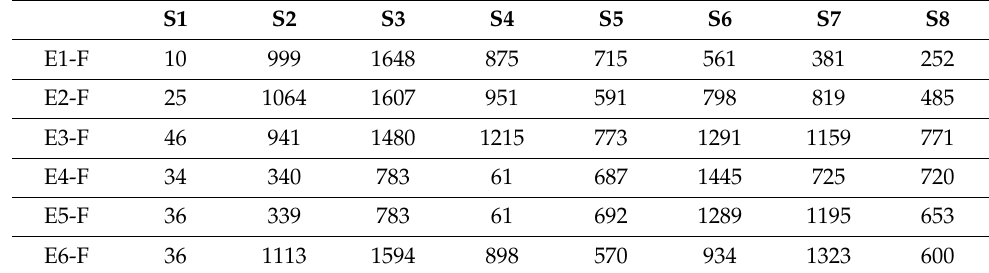
Table 4. The water age (day) of the sites 1–8 (S1, S2, S3, S4, S5, S6, S7, and S8 in Figure 4) after 5 years’ simulation for the six scenarios with farmland drainages (E1-F, E2-F, E3-F, E4-F, E5-F, and E6-F). S1 S2 S3